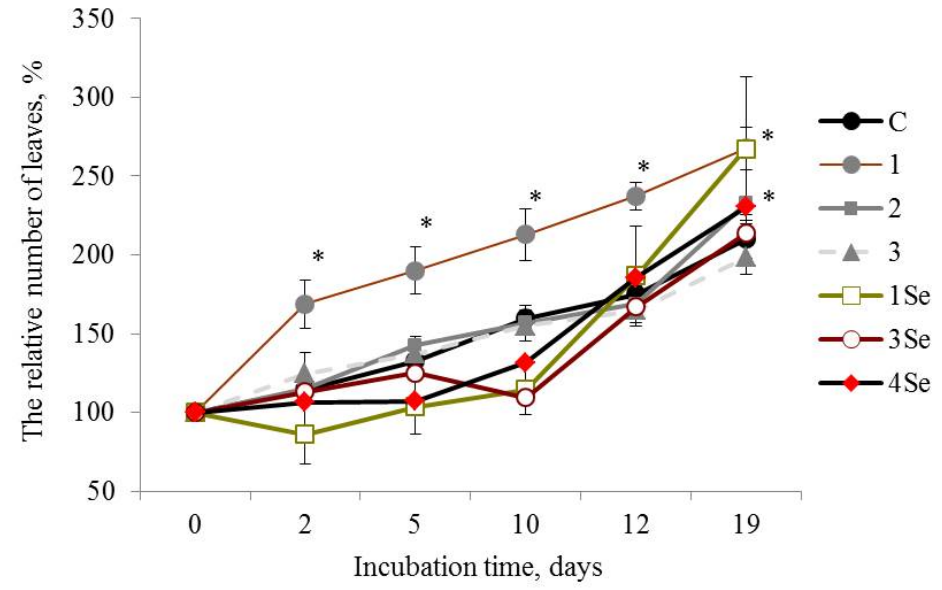
Figure 1. Influence of bio-composites on the relative (percentage to “0 day”) number of plant leaves in Lukyanovsky potato cultivar in vitro. C—control without treatment by fungal bio-composites; 1, 2 and 3—treatment by fungal biopreparations without Se based on Grifola umbellata , Ganoderma lucidum 1315 and Pleurotus ostreatus , respectively; 1Se, 3Se and 4Se—treatment by fungal bio-composites with Se based on Gr. umbellata ; P. ostreatus and G. lucidum SIE1303; * p ≤ 0.01 compared to